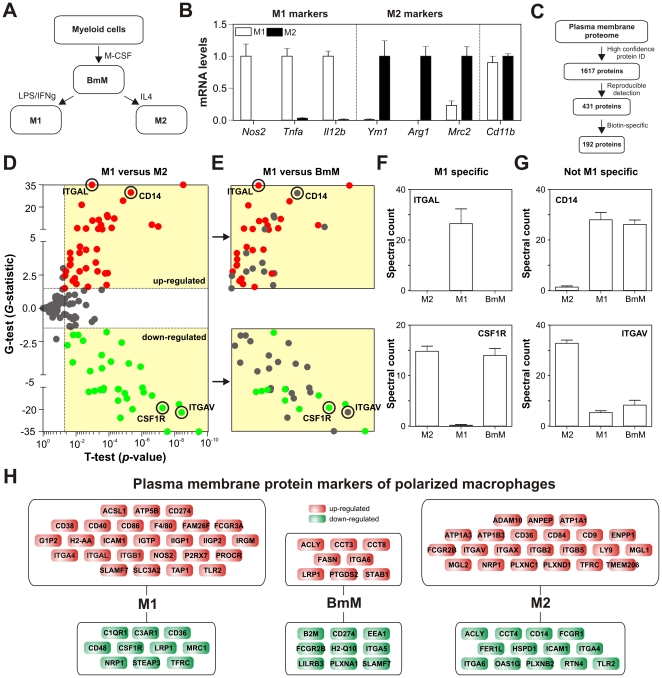
The plasma membrane proteome of macrophages.
Panel A: Bone marrow-derived macrophages (BmM) were derived from bone marrow precursor cells of C57BL/6 mice cultured with M-CSF. Classically activated macrophages (M1) and alternatively activated macrophages (M2) were derived from BmMs by treatment with IFN-γ and LPS or with IL-4. Panel B: qRT-PCR of markers used to detect M1 and M2 macrophages. Results (means and SEMs, N = 6) were standardized to 18S, expressed relative to the cell type with the highest expression of each gene, and are representative of 3 independent analyses. Panel C: LC-ESI-MS/MS analysis of plasma membrane proteins isolated from differentially activated macrophages. Proteins were quantified by spectral counting (total number of peptides identified for a given protein) and subjected to sequential criteria to identify 192 plasma membrane proteins that were reproducibly detected with high confidence. Panel D: Quantification of the membrane proteomes of M1 and M2 macrophages. Differentially expressed proteins (red, upregulated; green, downregulated; gray, not significantly different) were identified based on t-test and G-test statistics. Significance cutoffs (dashed lines; p<0.05 and G-statistic >1.5 or <−1.5) were determined based on permutation analysis (estimated FDR<5%). Panel E: Quantification of the membrane proteomes of M1 macrophages and BmMs. Proteins differentially expressed by M1 cells relative to both BmMs and M2 cells are indicated with colored dots (red, upregulated; green, downregulated). Proteins differentially expressed by M1 and M2 cells (Panel D) but not differentially expressed by M1 and BmMs are indicated by gray dots. Panel F: Examples of proteins that distinguish M1 cells from both BmM and M2 cells (CSF1R, ITGAL). Results (N = 6 per group) are means and SDs. Panel G: Examples of proteins that fail to distinguish M1 cells from both BmM and M2 cells (CD14, ITGAV). Panel H: Plasma membrane proteins differentially expressed by M1 cells (36 proteins), M2 cells (35 proteins), and BmMs (17 proteins).